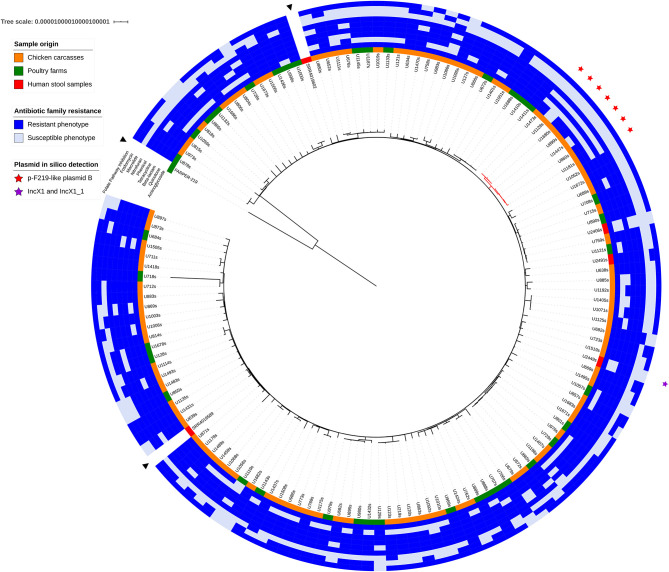
Maximum likelihood phylogenetic tree of core genome alignment of all 137 S. Infantis isolates based on 3,552 genes. Two S. Infantis genomes from Ecuador detected in USA (SRR4019589, SRR4019602) and a Peruvian strain (FARPER-219) were included in the analysis and are indicated with a black triangle. The origin of each sample is colored in red for human stool samples, in green for poultry farms isolates and in orange for chicken carcasses strains. The phenotypic resistance for nine antibiotic families is marked with a blue box. Strains with p-F219-like plasmid B are marked with a red star. The rest of the samples harbor the p-F219-like plasmid A. The purple star indicates the presence of IncX1 and IncX1_1 plasmids in one of the strains. Digital version of the phylogenetic tree is available with iTOL login LMejia at https://itol.embl.de/shared_projects.cgi.